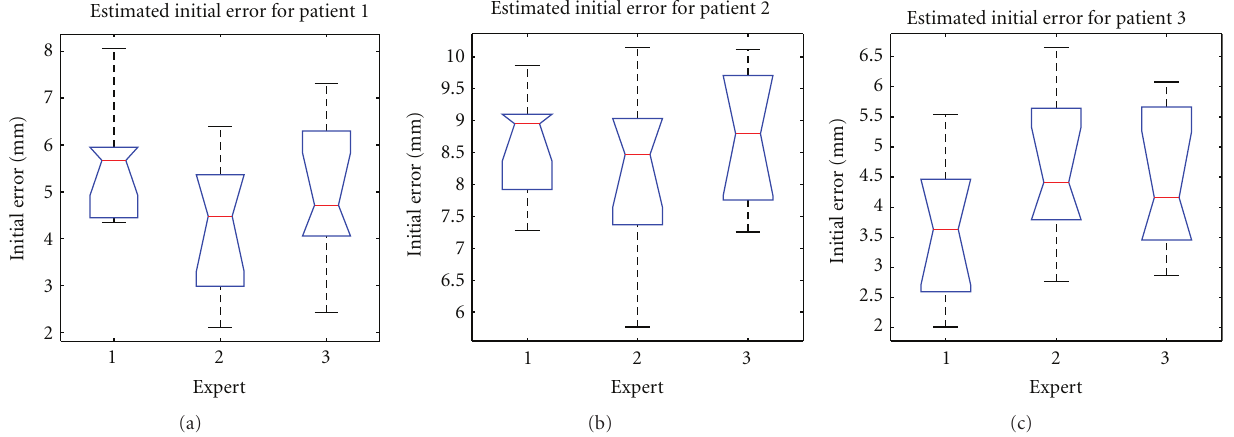
Figure 8: Initial errors (in mm) estimated by all experts for the each patient.